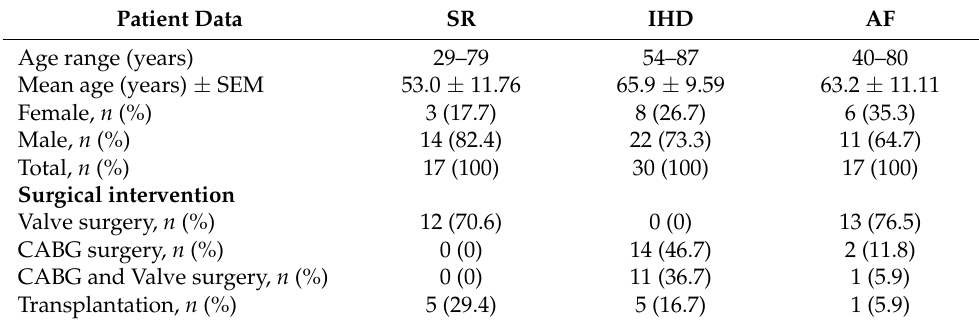
Table 1. Clinical characteristics of the